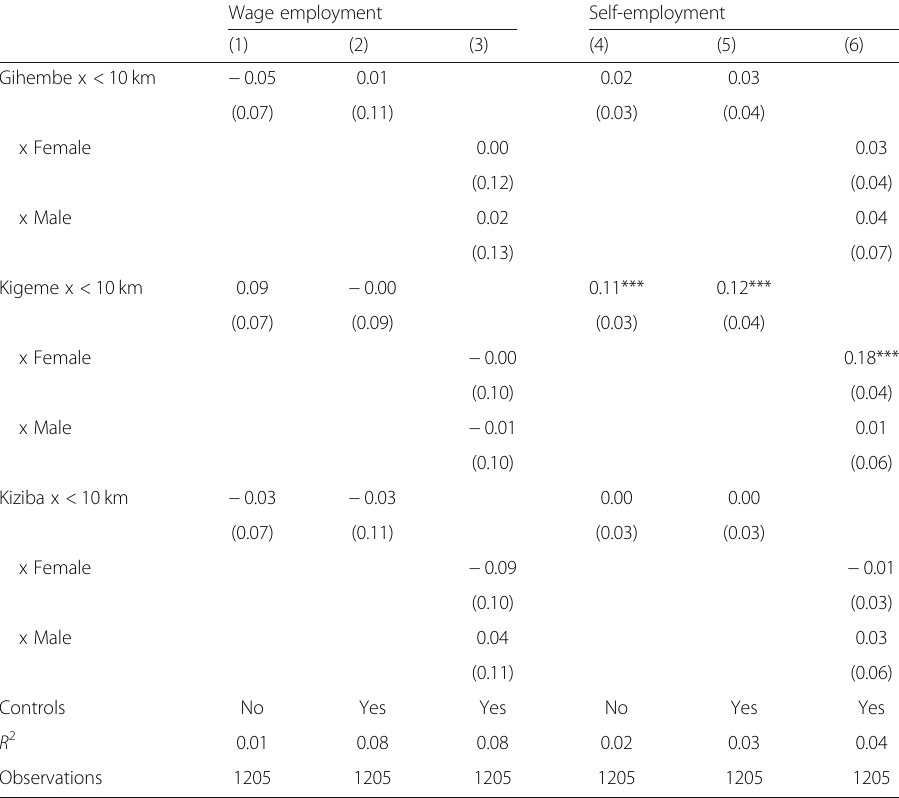
Table 10 Secondary activity of those in subsistence farming/livestock, by camp area Wage employment